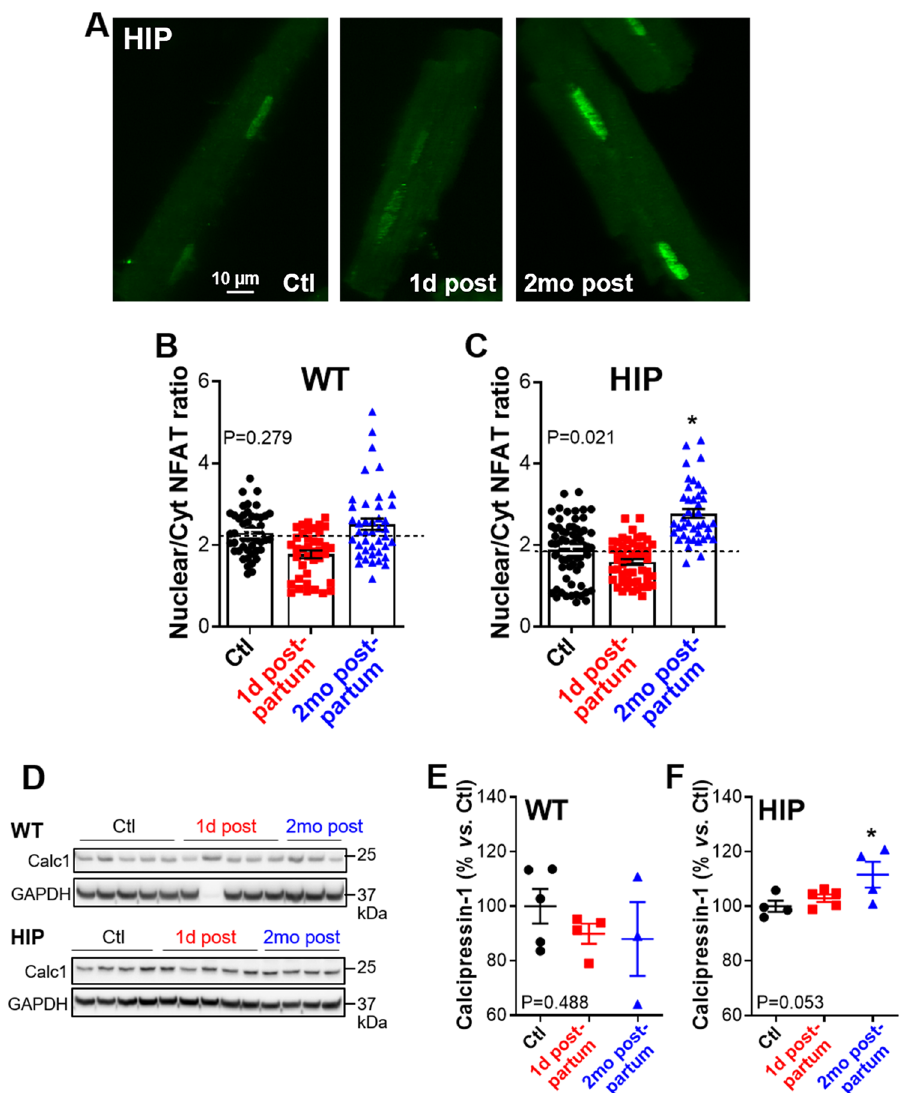
Figure 3. Nuclear versus cytosolic localization of NFATc4 in myocytes from HIP and WT females. ( A ) Examples of immunofluorescence images in myocytes from HIP females in the control (Ctl), 1 day postpartum (1d post) and 2 months postpartum (2mo post) groups. Cells were labeled with an anti-NFATc4 antibody. ( B,C ) Mean ratio of nuclear-to-cytosolic NFATc4 signal in cells from WT ( B ) and HIP ( C ) females in the control (WT: 4 females, 10–15 cells/rat; HIP: 6 females, 9–14 cells/rat), 1 day postpartum (WT: 3 females, 11–16 cells/ rat; HIP: 5 females, 7–13 cells/rat) and 2 months postpartum (WT: 4 females, 10–11 cells/rat; HIP: 4 females, 9–12 cells/rat) groups. The number of cells per each rat is shown in Supplementary Table 1. ( D–F ) Expression of calcipressin-1 in hearts from control (Ctl), one day postpartum and two months postpartum WT and HIP females. Representative examples ( D ) and relative band intensities ( E,F ). Data for the sample loaded into Lane 7 of the WT gel were excluded from analysis. Data for animals in control groups sacrificed at the time when pregnancy groups were at 1 day and 2 months postpartum were pooled. Statistical analysis was performed with a mixed model using the Nested One-Way ANOVA analysis in Prism 8.1.2 (panels B and C ; P values are shown on the graph) or One-way ANOVA (panels E and F ; P values are on the graph) and Dunnett’s post-test for multiple